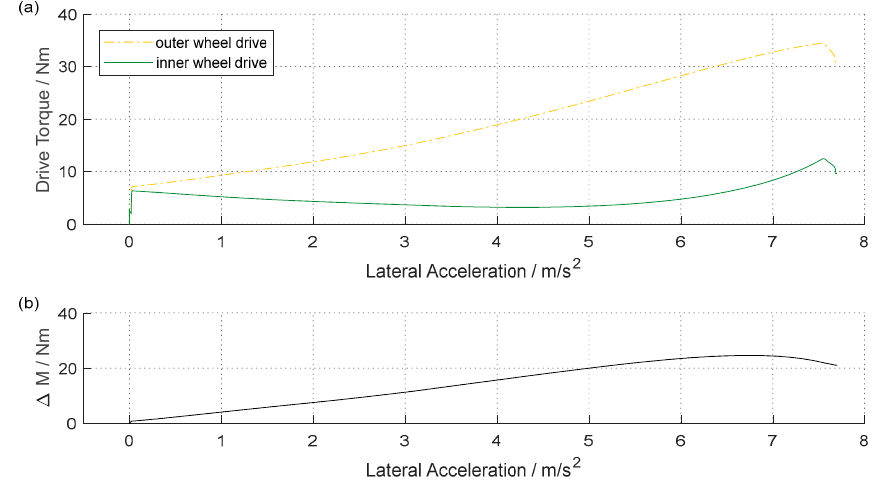
Figure 7. Quasi-steady-state circular operation: ( a ) drive torques of outer and inner wheel drives and ( b ) difference between the drive torques over later acceleration.